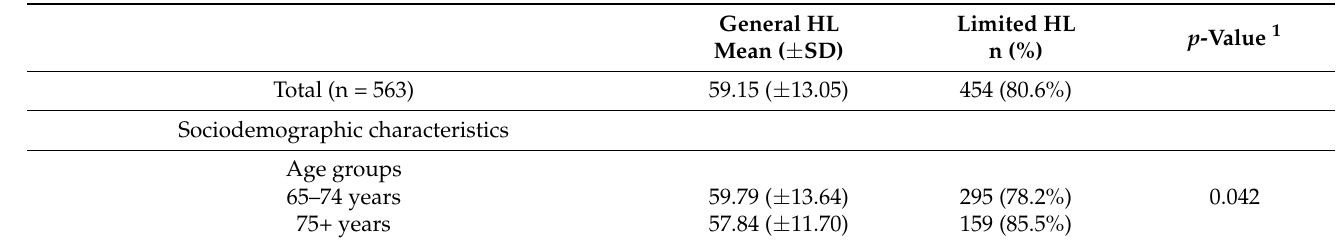
Table 2. General health literacy score means and limited health literacy by sociodemographic, health and healthcare-related